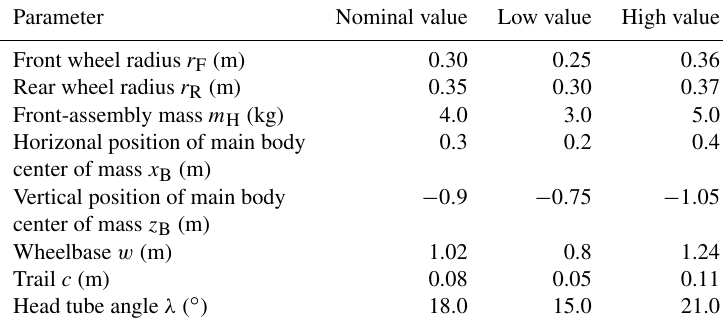
Table 2. Nominal values and ranges of geometric and mass